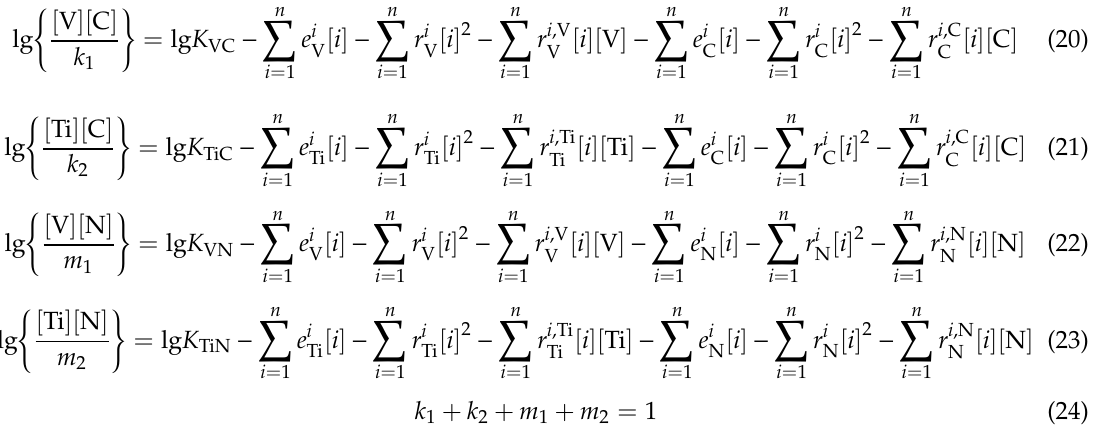
Table 2. Interaction parameters e j